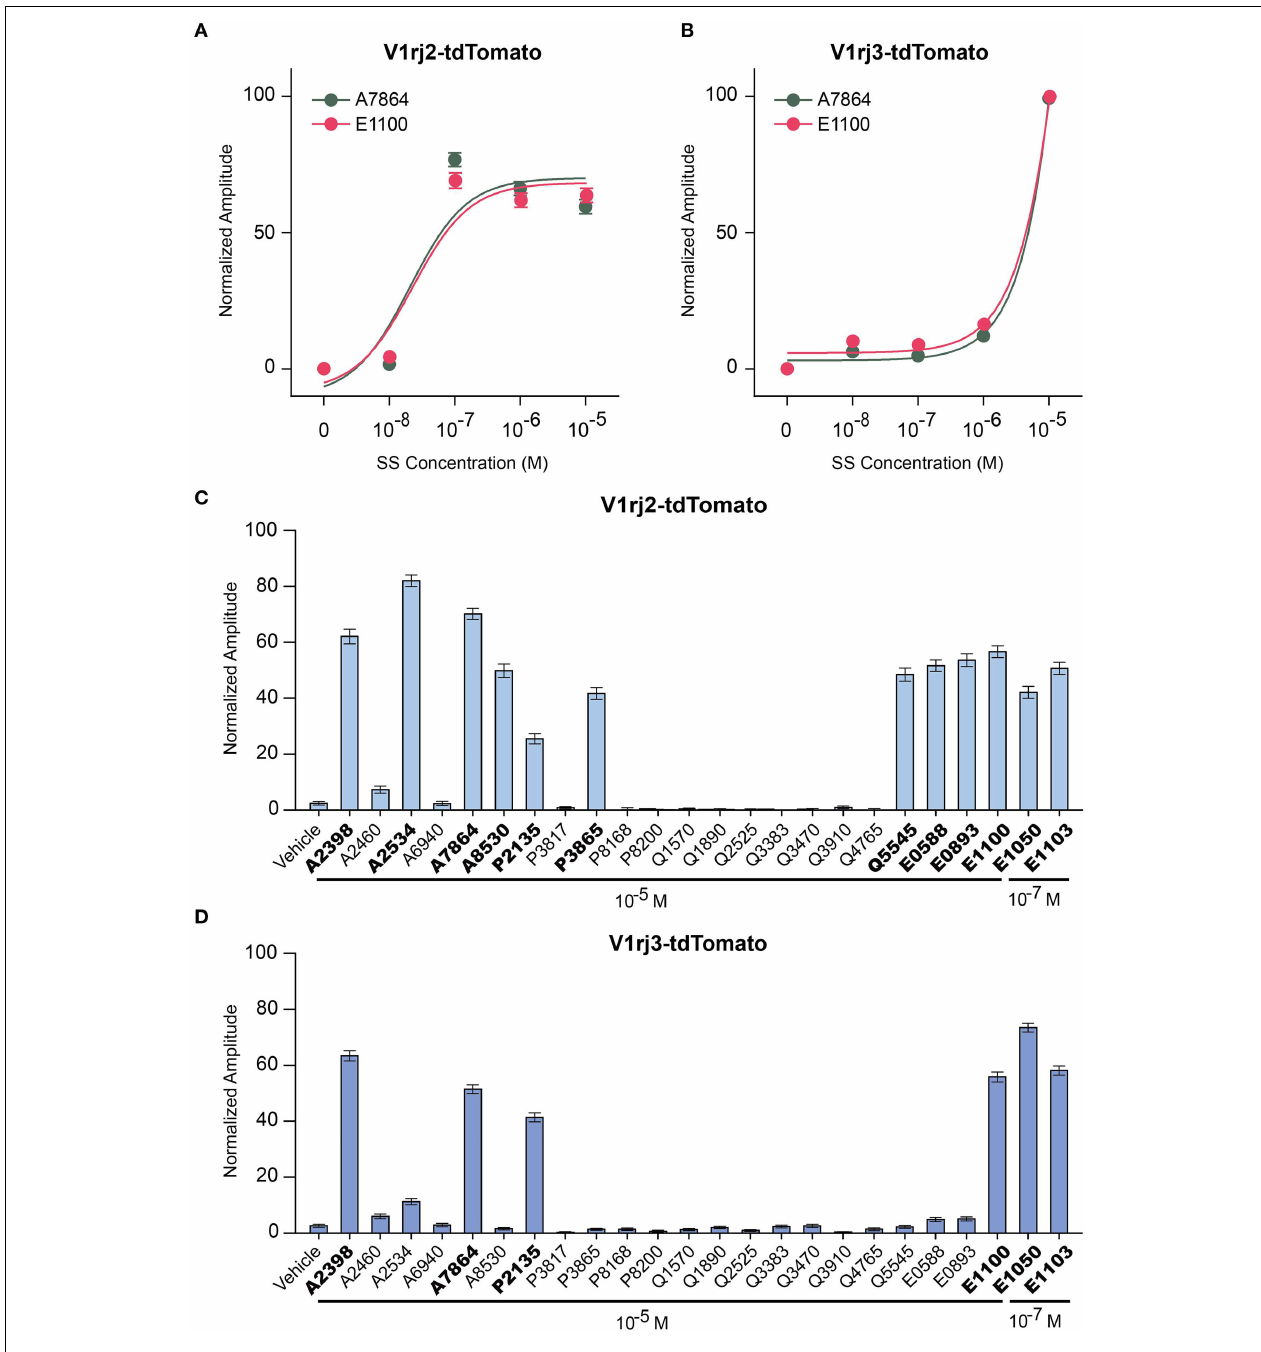
A7864 ( n = 249 ) and E1100 ( n = 249 ). (C,D) Bar graphs showing the normalized response of V1rj2 ( C ; n = 183 ) and V1rj3 ( D ; n = 373 ) cells a panel of sulfated steroid compounds. Error bars,